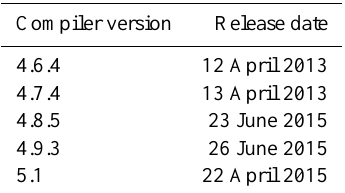
Table 4. Five latest versions of the GCC compilers. The release date of a given compiler version in the table is the release date of its latest revision